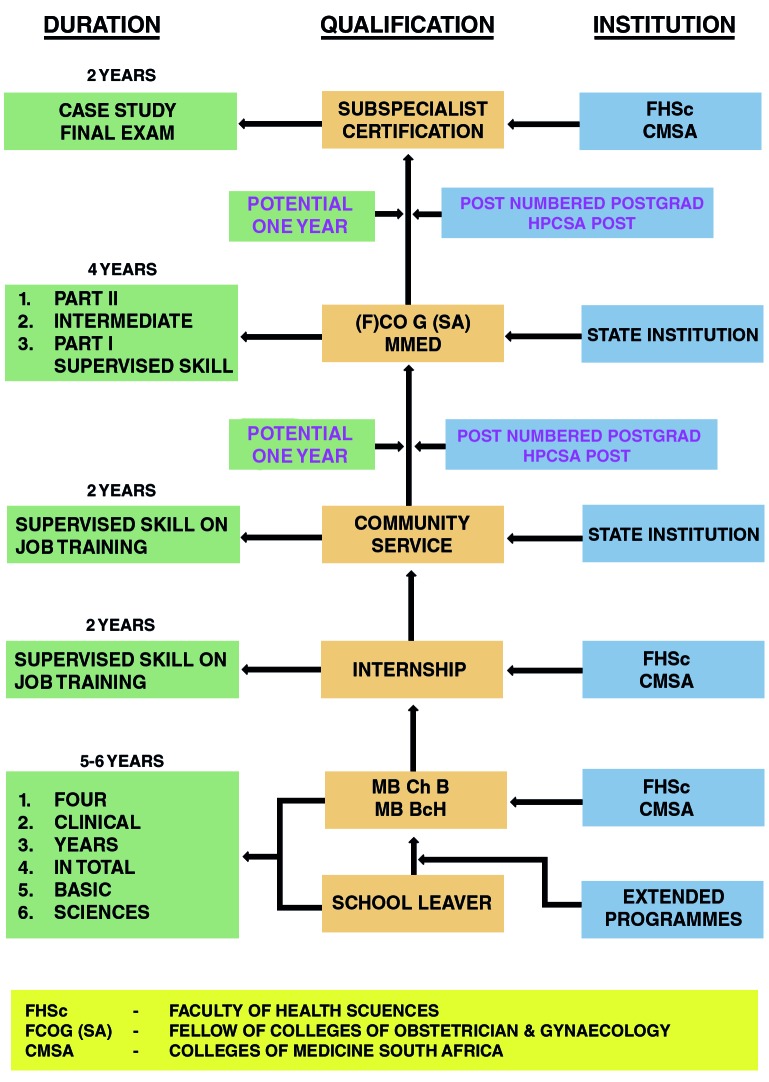
— Current model of training subspecialists in South AfricaSource: Authors own compilation.